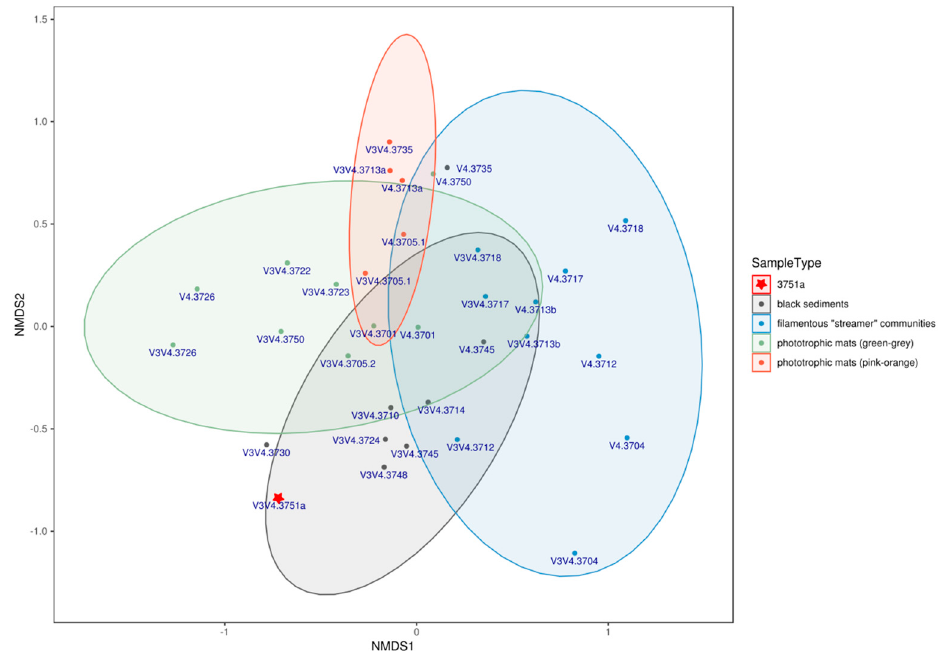
Figure 3. NMDS based on the taxonomic profiles of samples. Ellipse lines, drawn using stat_ellipse function of ggplot2 R package [27] assuming a multivariate t-distribution, are based on the variance observed among each group of samples, except sample 3751a, being a single sample from the Chaplino group. The stress level of analysis returns a value of 0.178, which is considered an acceptable adjustment over the 2D plane. ANOSIM analysis of chosen sample groups showed a significance value of 0.001 and ANOSIM statistic value of 0.4314 which reflects a significant difference between chosen groups.